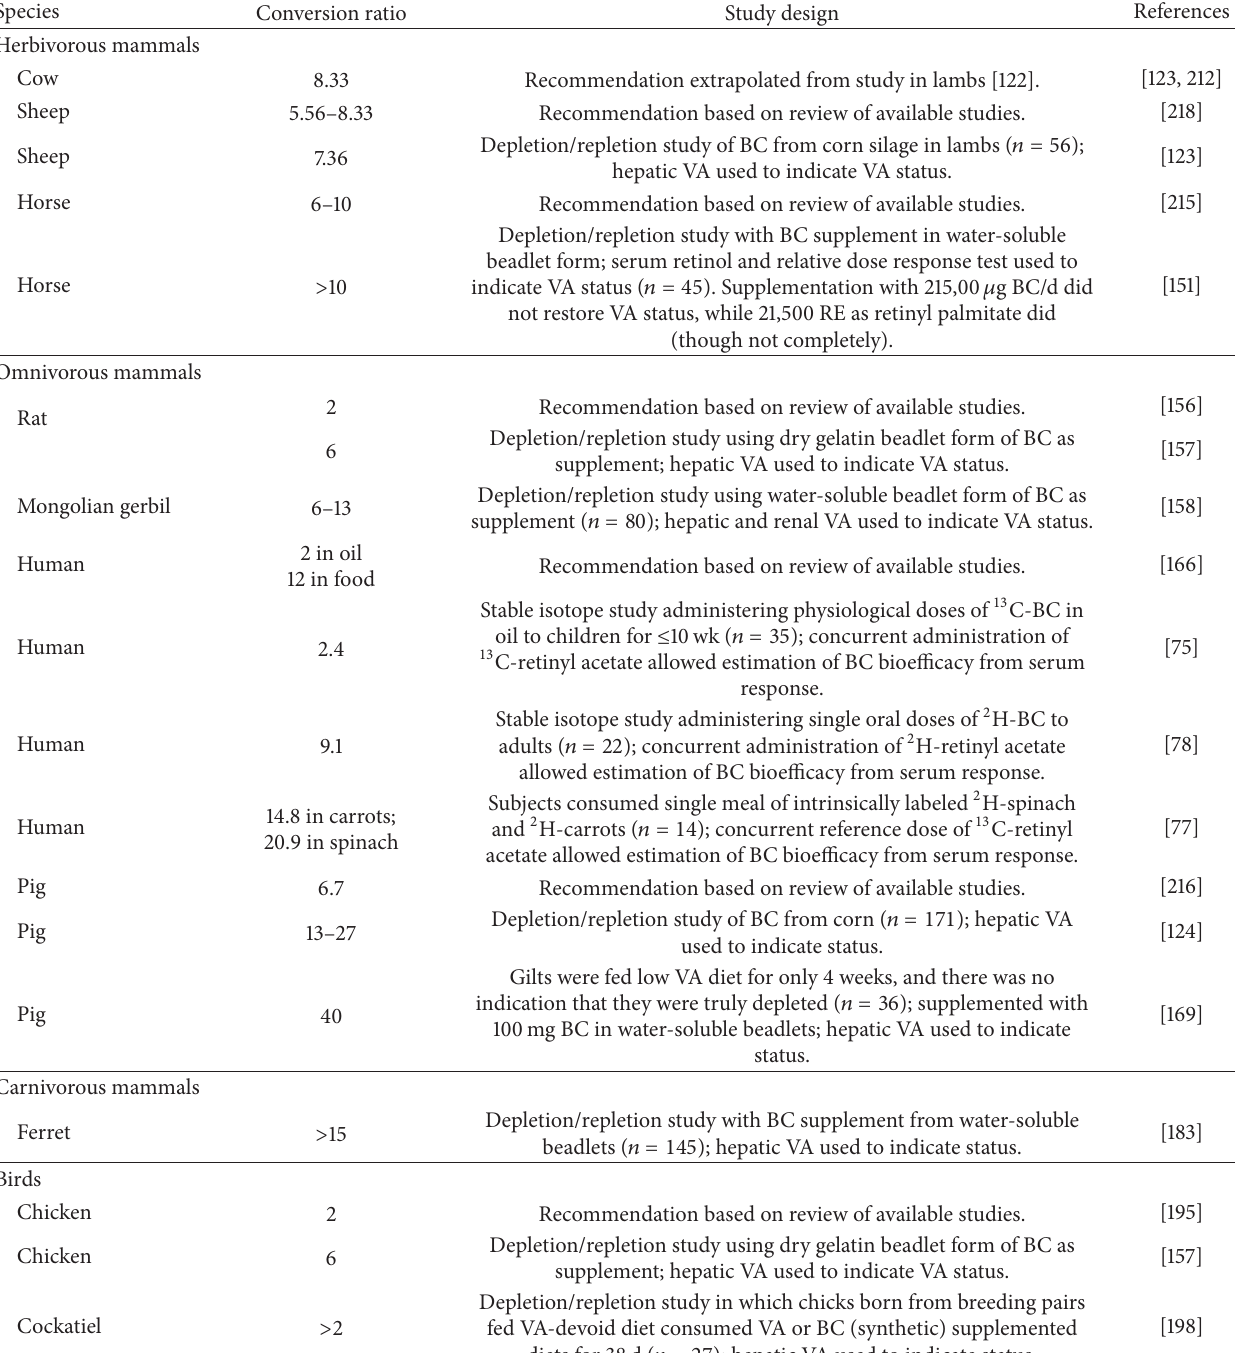
Table 2: Estimated efficiency of conversion of 𝛽 -carotene to vitamin A in animals, defined as 𝜇 g of 𝛽 -carotene required to form 1 RE (1 𝜇 g retinol). The 𝑛 value given is the total number of animals in the